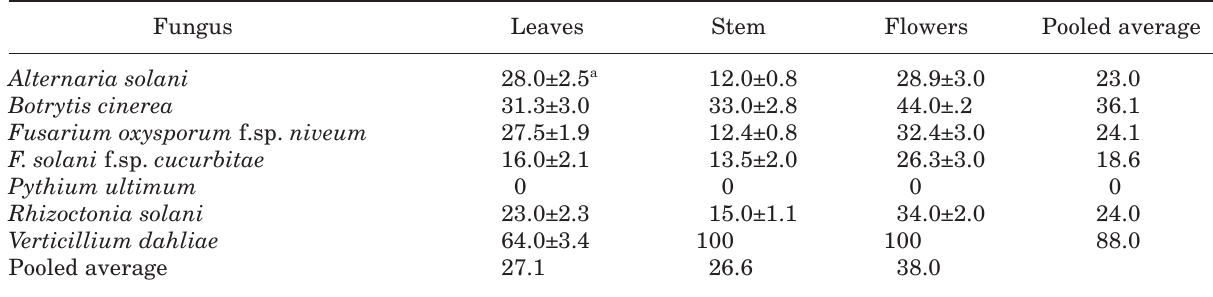
Table 3. Inhibition (%) of fungal growth with different parts of Lantana camara.